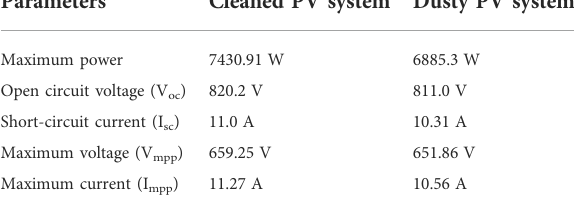
TABLE 8 Parameters of the photovoltaic systems for June.